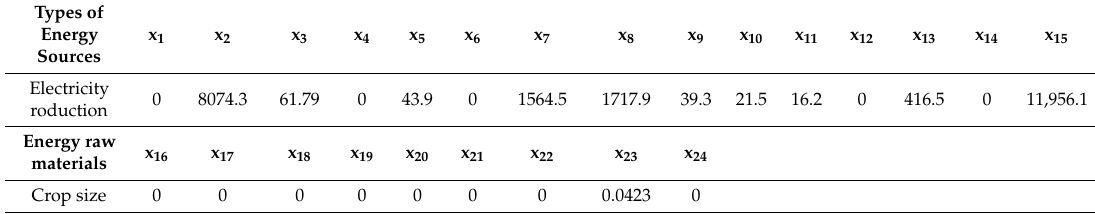
Table 15. Results of scenario II run for